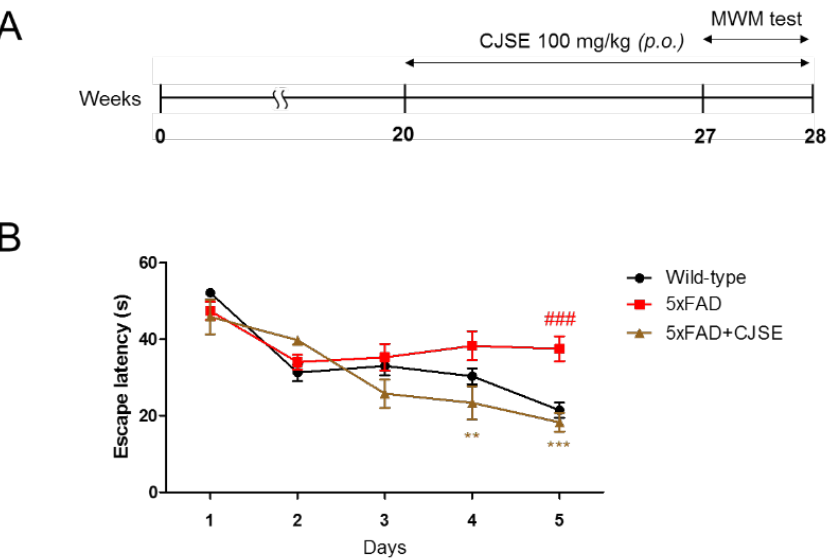
Figure 1. Effects of Cuscutae Japonicae Semen extract (CSJE) treatment on memory impairment in 5x familiar AD (5xFAD) mice. ( A ) Time scheme of the CJSE treatment and Morris water maze (MWM) test. ( B ) Escape latencies of wild-type, 5xFAD, or CJSE-treated 5xFAD mice. Values are indicated as the mean ± S.E.M. ### p < 0.001 compared to wild-type mice; ** p < 0.01 and *** p < 0.001 compared to 5xFAD mice.